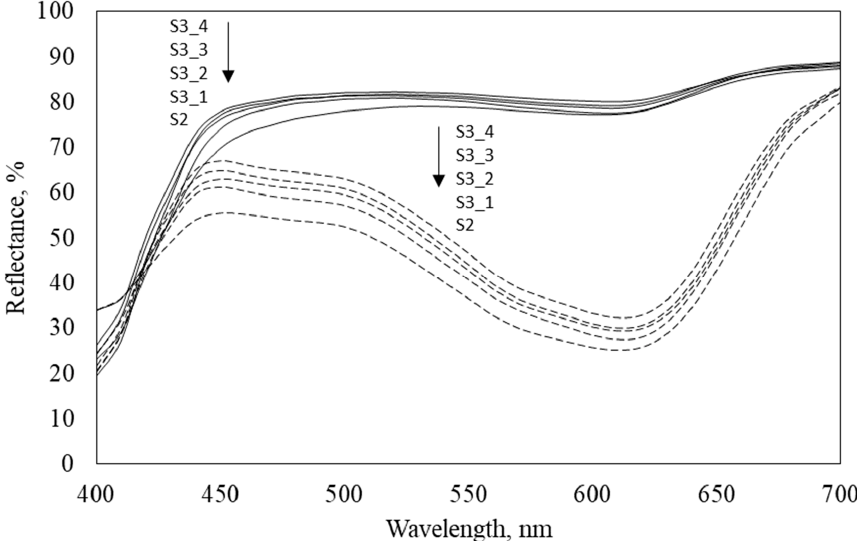
Figure 2. Reflectance curves of coated samples before (—) and after ( ‒ ‒ ) irradiation with UVA light.